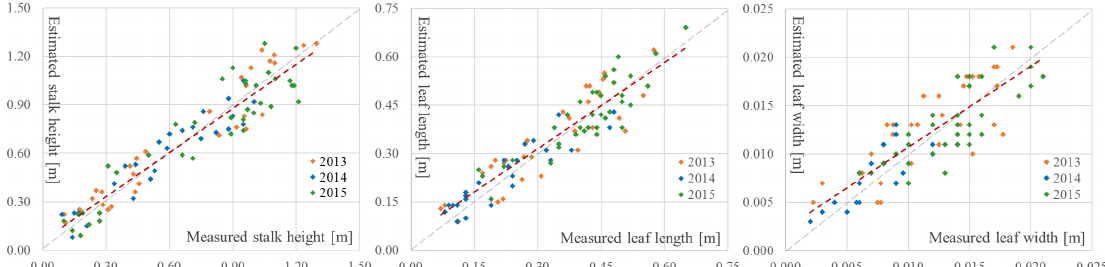
Figure 5. The measured values of stalk height, leaf length and leaf width parameters versus their estimations given in a correlation scatter plot for years 2013 to 2015 with a reference line. Symbols are colored with respect to the year: 2013 ( ◆ ), 2014 ( ◆ ) and 2015 ( ◆ ).